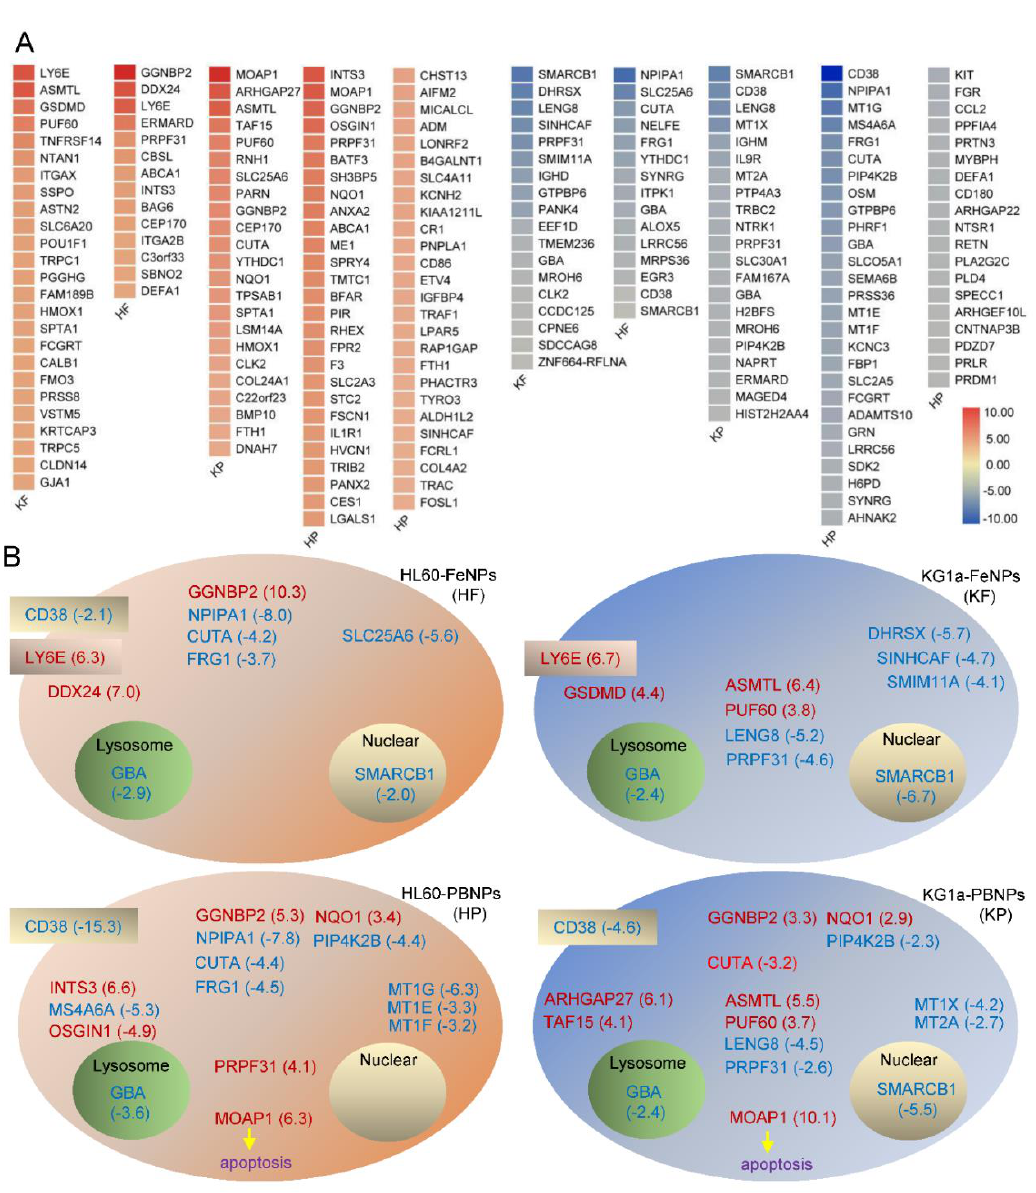
Figure 3. Gene signatures of two Leukemia cells treated by two kinds of iron nanoparticles: ( A ) most significantly regulated DEGs (fold change > 2.0) in two cell lines treated by two kinds of iron nanoparticles and ( B ) schematic of signature genes (fold change > 2.0) in two cell lines treated by two kinds of iron nanoparticles. The common genes were placed at the same positions in schematic cells for comparing.